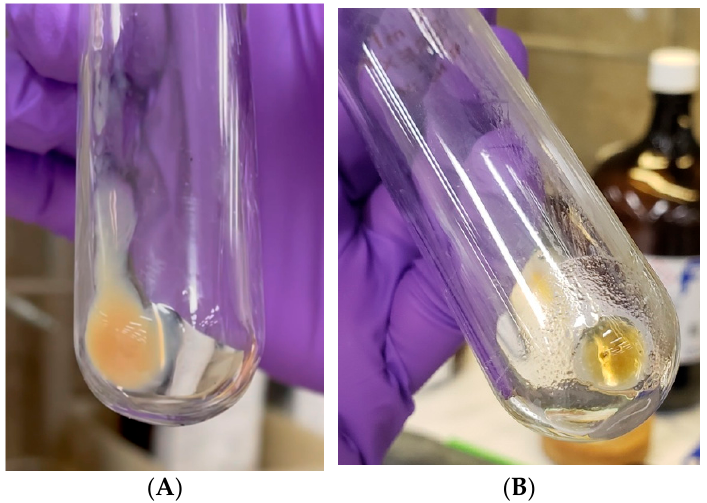
Figure 6. ( A ) Kdo 2 -Lipid A pelleted after precipitation; ( B ) Kdo 2 -Lipid A after washes with phenol.